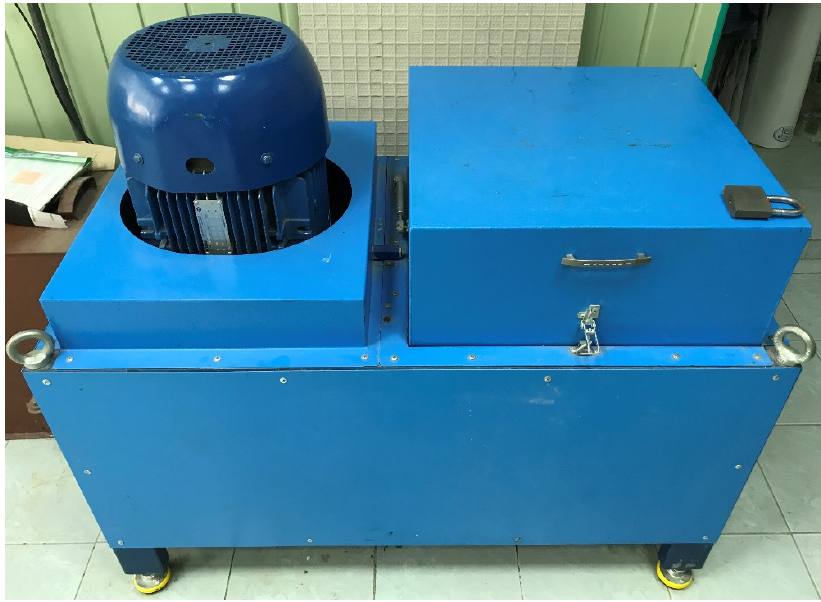
Figure 2. General view of the planetary ball mill “Activator—4M”.